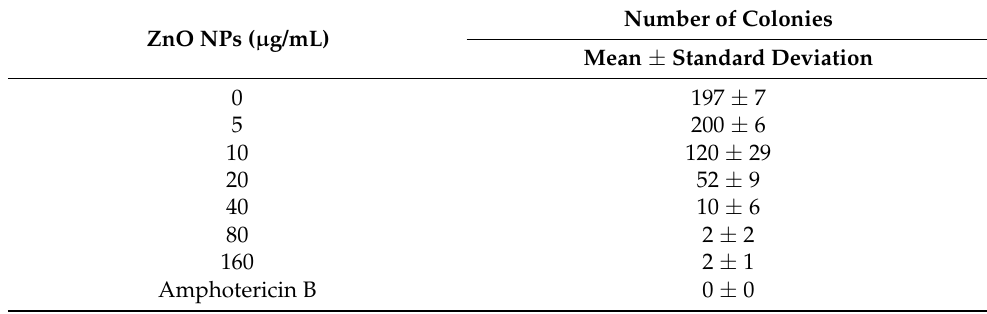
Figure 4. Colonies of C. albicans formed on SDA at 35 ◦ C after 24 h incubation in a negative con- trol, a positive control, and yeast suspensions treated with 5 µ g/mL and 10 µ g/mL ZnO NPs ( A ), 20 µ g/mL and 40 µ g/mL ZnO NPs ( B ), and 80 µ g/mL and 160 µ g/mL ZnO NPs ( C ). Table 1. Number of colonies formed on SDA after 24 h incubation.